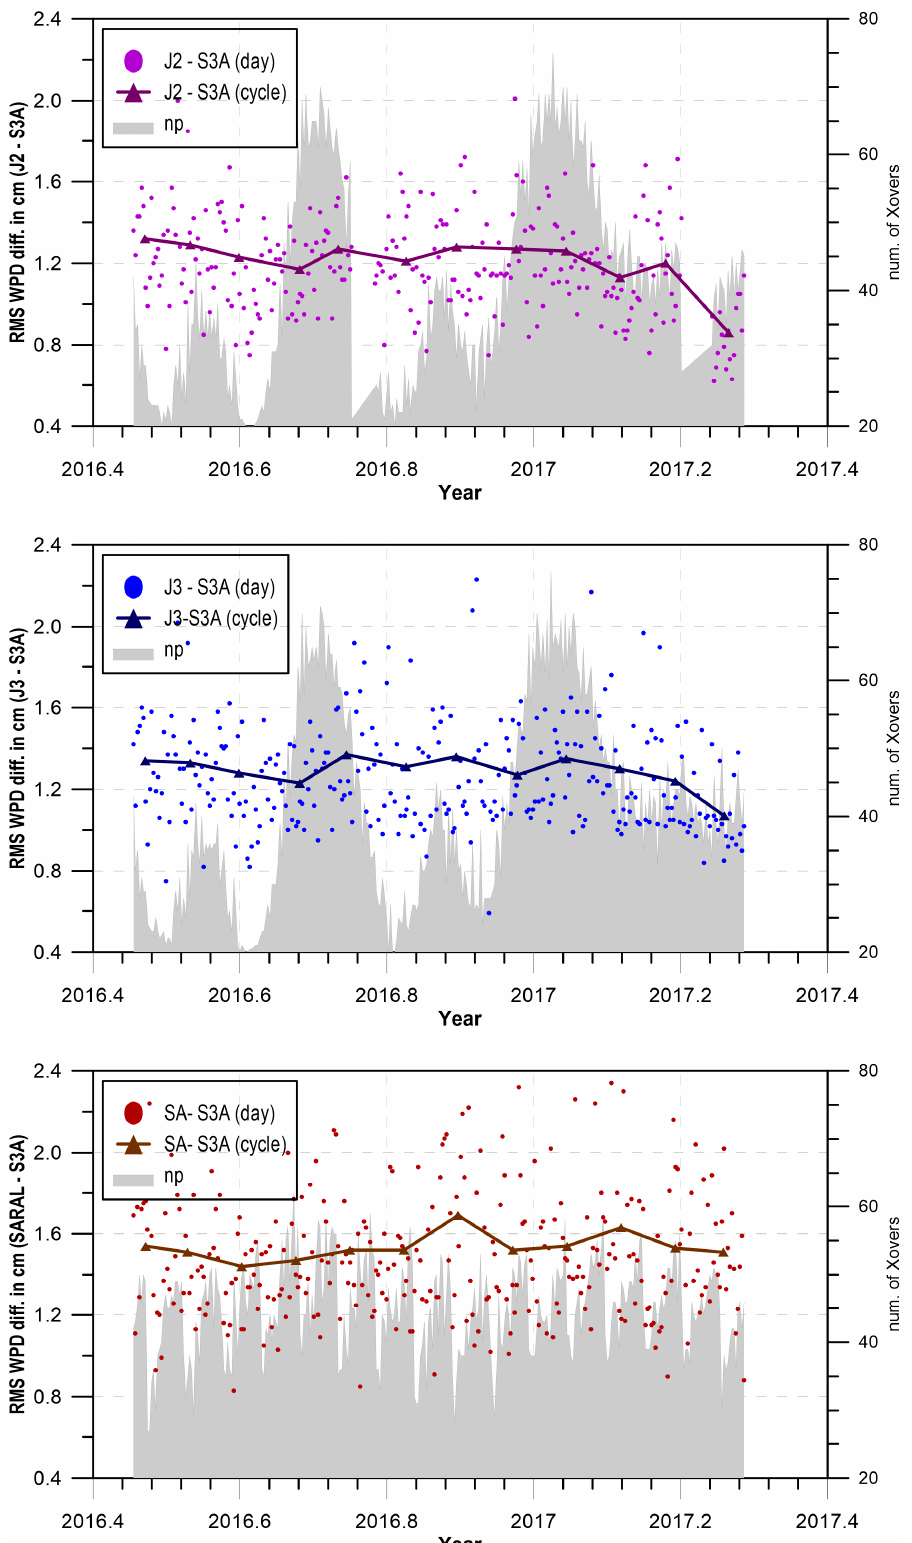
Figure 10. Time evolution of daily and 27 ‐ day RMS WPD differences between J2 and S3A ( Top ), between J3 and S3A ( Middle ), and between SARAL and S3A ( Bottom ), in cm.